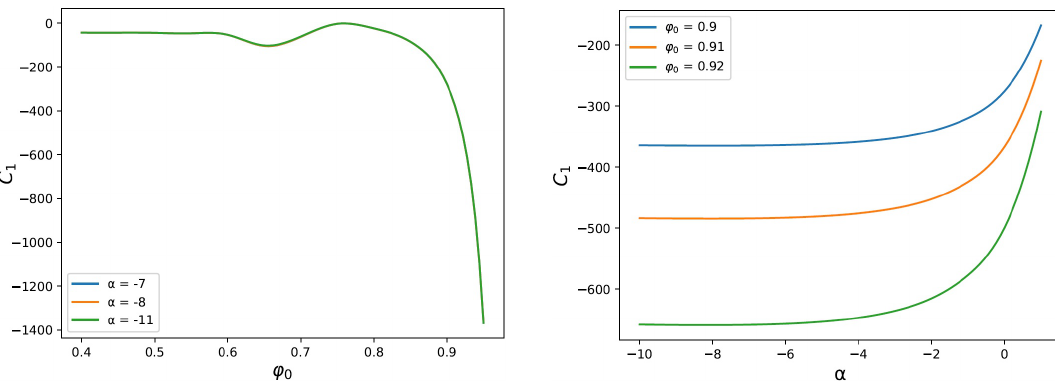
Figure 13 . Left: the integration constant C 1 as a function of ϕ 0 for fixed values of α , for Nut end-point solutions. Right: C as a function of α for fixed values of ϕ 1